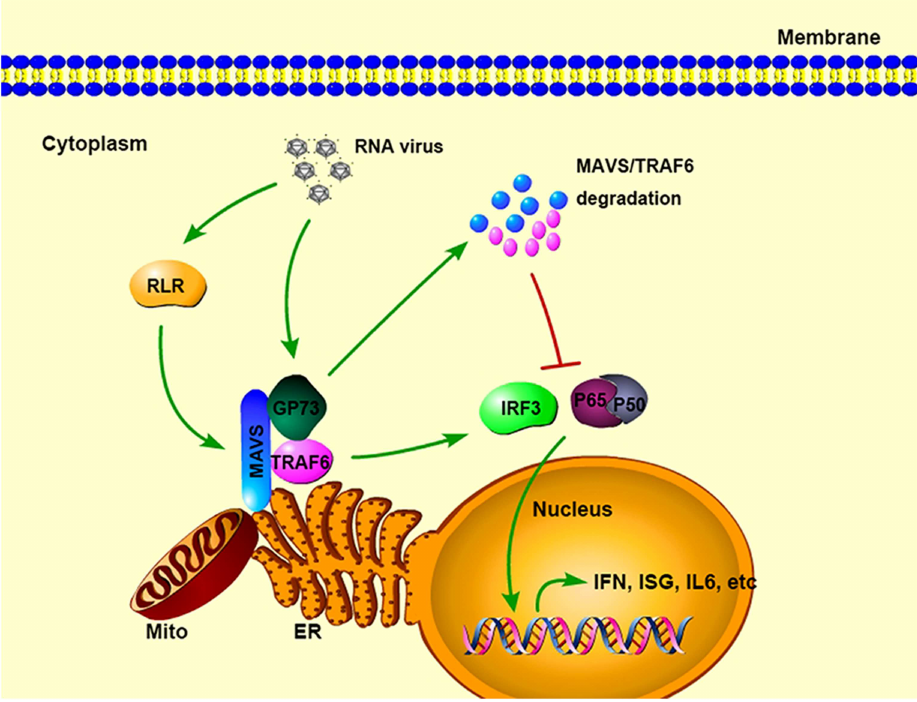
TRAF6 to facilitate MAVS and TRAF6 proteasome-dependent degradation, leadingto the repressionof host innate immunity and facilitation of HCV